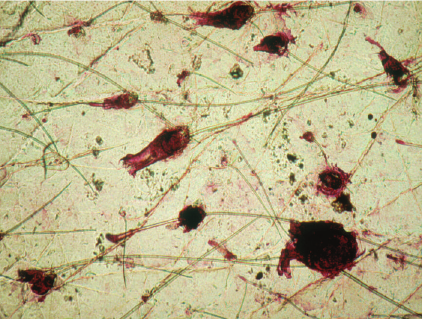
Figure 11: Comedometry-microcomedones of various sizes in acne.